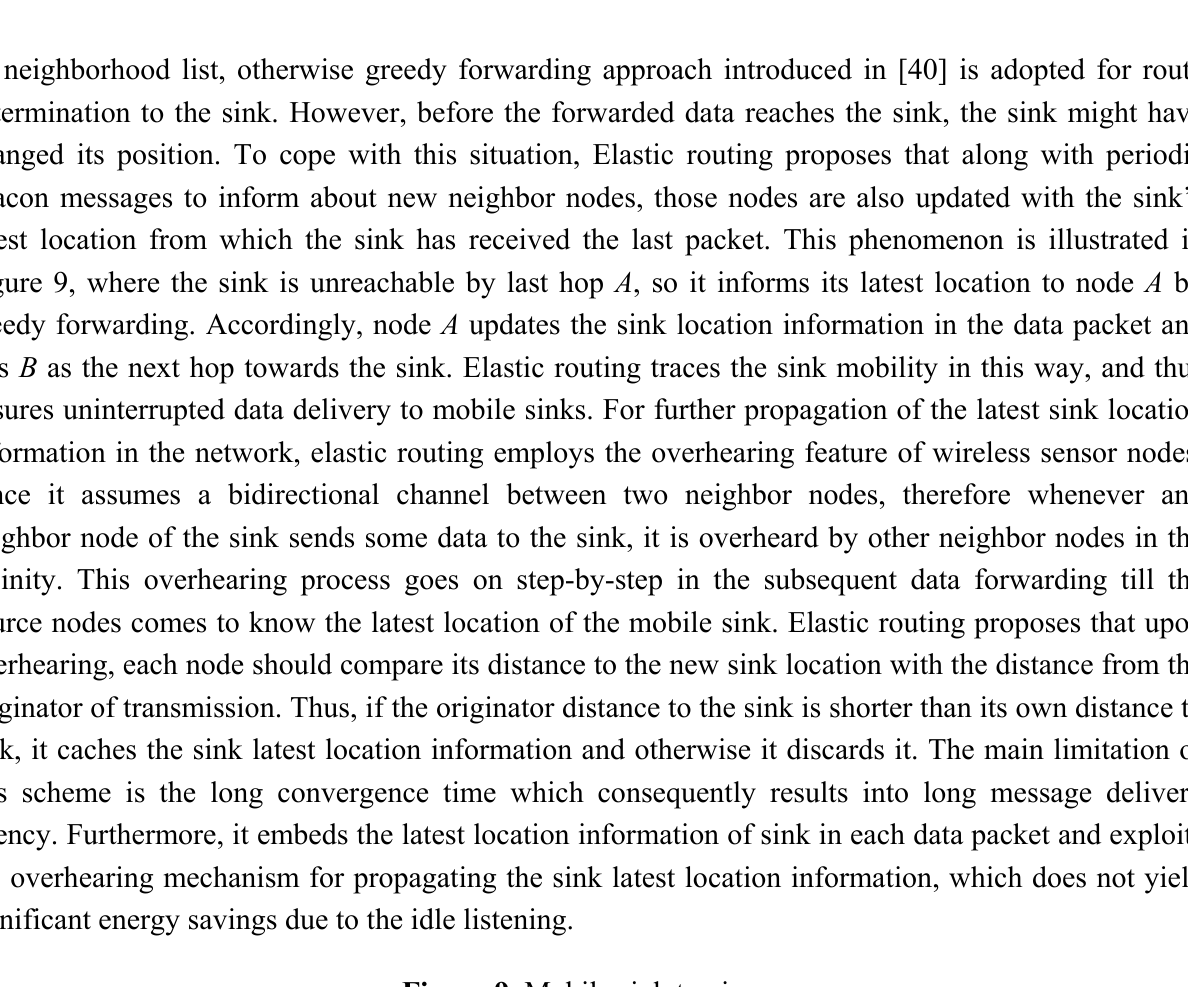
Figure 9. Mobile sink